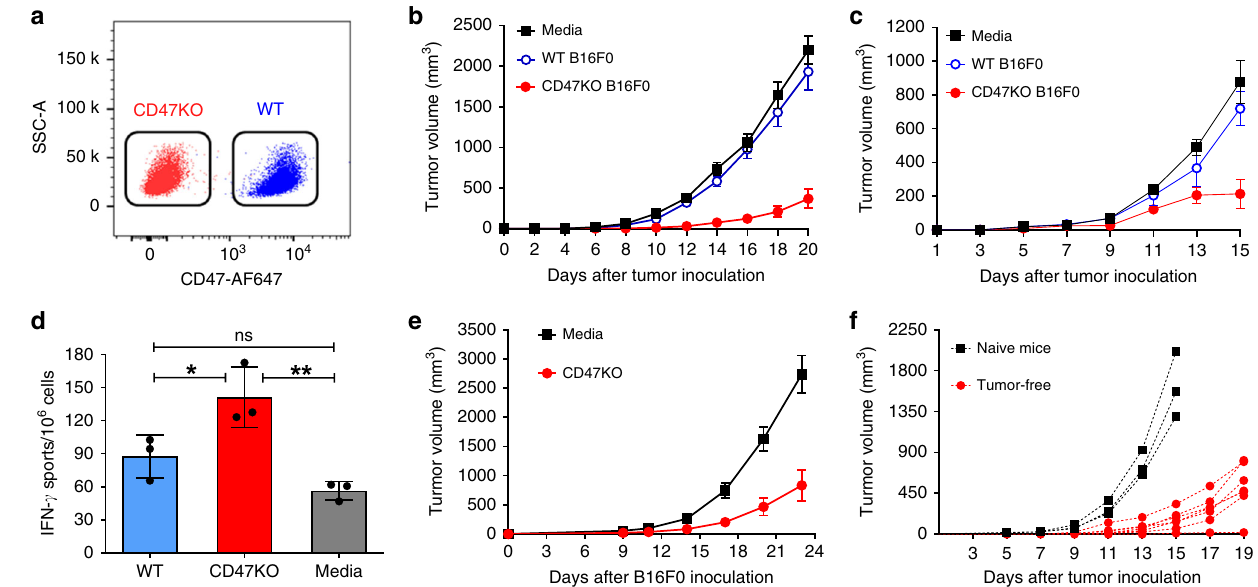
Fig. 1 Antitumor responses achieved by CD47KO tumor cell vaccination. a Representative fl ow cytometry pro fi les showing CD47 expression on wild- type (WT) and CD47KO B16F0 cells. CD47KO cells were generated by CRISPR/Cas9-targeted inactivation of cd47 gene. b B6 mice were injected (i.s.) with media ( n = 19), or with irradiated WT ( n = 16) or CD47KO ( n = 20) B16F0 cells, followed 7 days later by subcutaneous injection of 2 × 10 5 WT B16F0 melanoma cells. c B6 mice were injected (i.s.) with media ( n = 4 at days 11 and 13; n = 9 at other time points), or with WT ( n = 4 at days 11 and 13; n = 7 at all other time points) or CD47KO ( n = 5 at days 11 and 13; n = 10 at all other time points) B16F0 cells that were treated with mitomycin C (at 40 µ g/mL for 2h), followed 7 days later by subcutaneous injection of 2 × 10 5 WT B16F0 melanoma cells. d Spleen cells were harvested from mice 7 days after